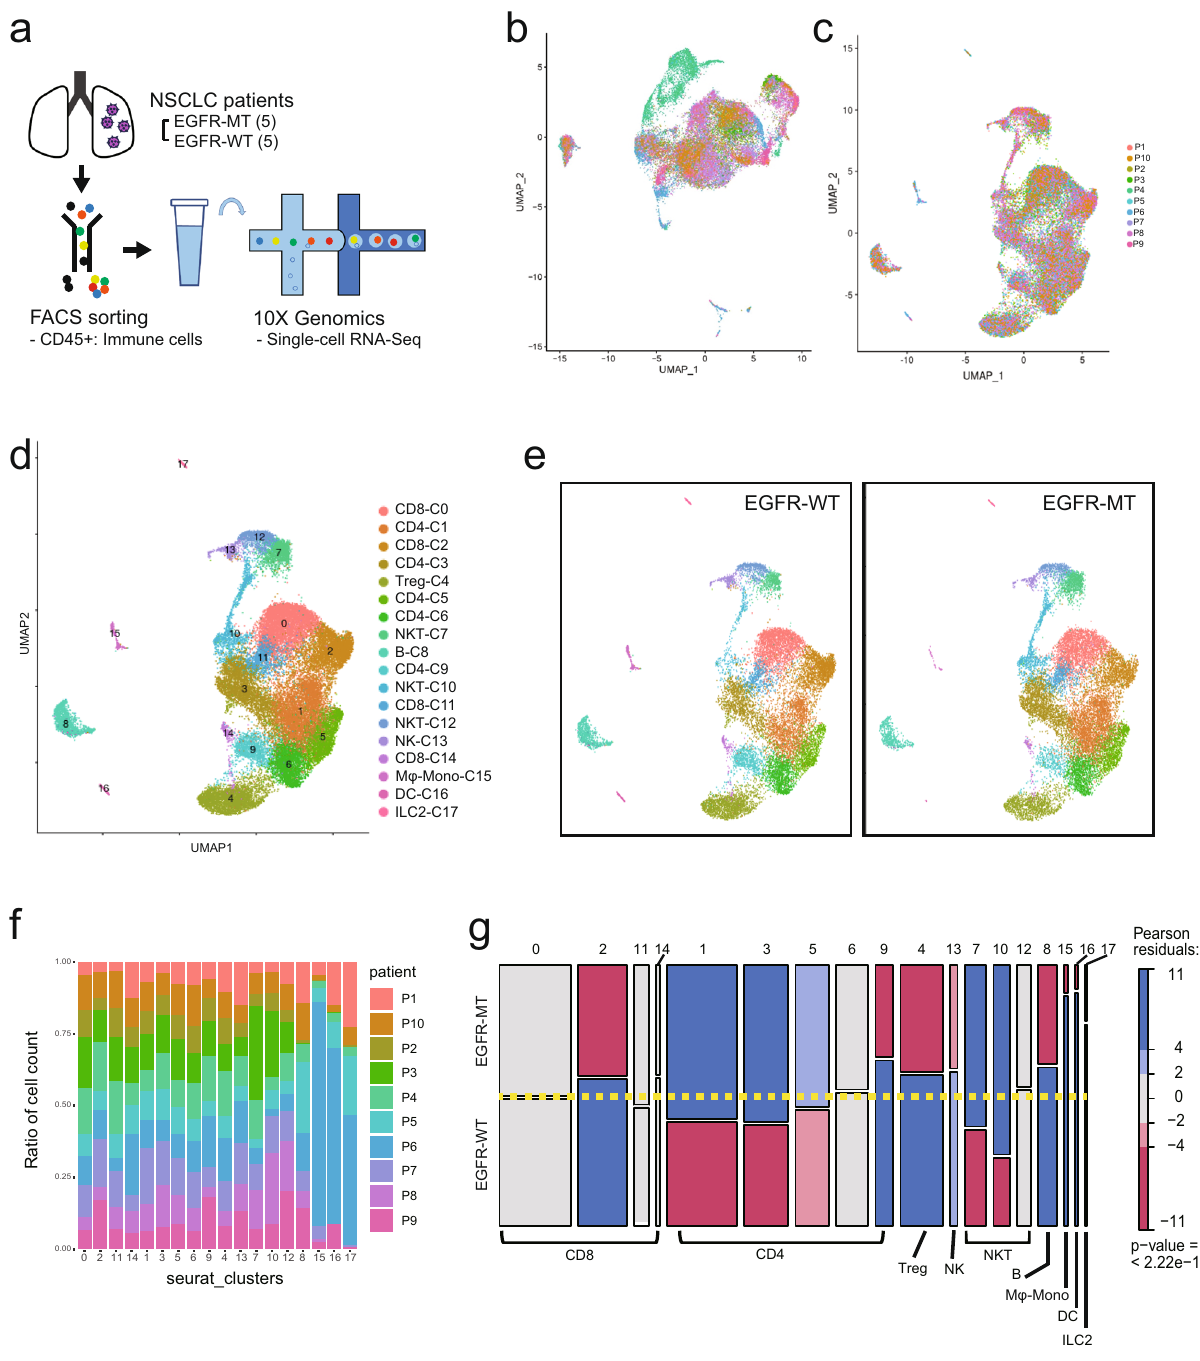
0.250.500.751.00 Fig. 1 Overview of comparative scRNA-seq analysis for lung tumor samples. a Schematic overview of scRNA-seq analysis for lung tumor samples from 10 patients (P1 – 10) of mutant or wild-type EGFR. b , c UMAP visualization of scRNA-seq data before ( b ) and after ( c ) batch correction. d UMAP plot of 18 clusters (C0 – 17) of immune cells categorized into major immune cell types. The order of cluster number corresponds to the relative cell count. Clusters were annotated by canonical marker gene expression. e UMAP plot of 18 clusters of immune cells from either EGFR-WT (left) or EGFR-MT (right). f Stacked-barplot of the cell count for each patient in 18 clusters. g Mosaic plot of 18 clusters, each of which is composed of EGFR-WT and EGFR-MT groups. Red color indicates signi fi cantly decrease in abundance, whereas blue color indicates signi fi cantly increase in abundance (|Pearson residual| > 2 for p -value < 0.05, |Pearson residual| > 4 for p -value < 0.0001). The p -value shown in the mosaic plot was obtained from a one-sided chi-square test. Source data are provided as a Source Data fi successful interpretation of differentially accumulated subsets between EGFR-WT and EGFR-MT would provide clues to understanding the mechanisms underlying unfavorable anti-PD- 1 response in patients with EGFR-MT NSCLC. To characterize